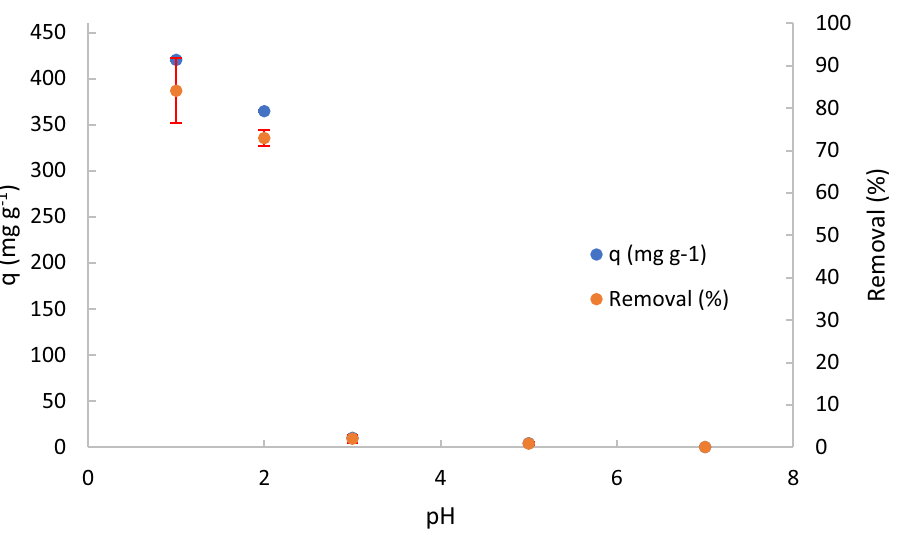
Figure 5. Effect of pH on DFC removal by TPEG and its adsorption capacity. C o = 100 mg L −1 , contact time = 22 h, Solution volume = 50 mL, mass of adsorbent = 10 mg, stirring speed = 650 rpm. Standard deviation is also reported for each experimental